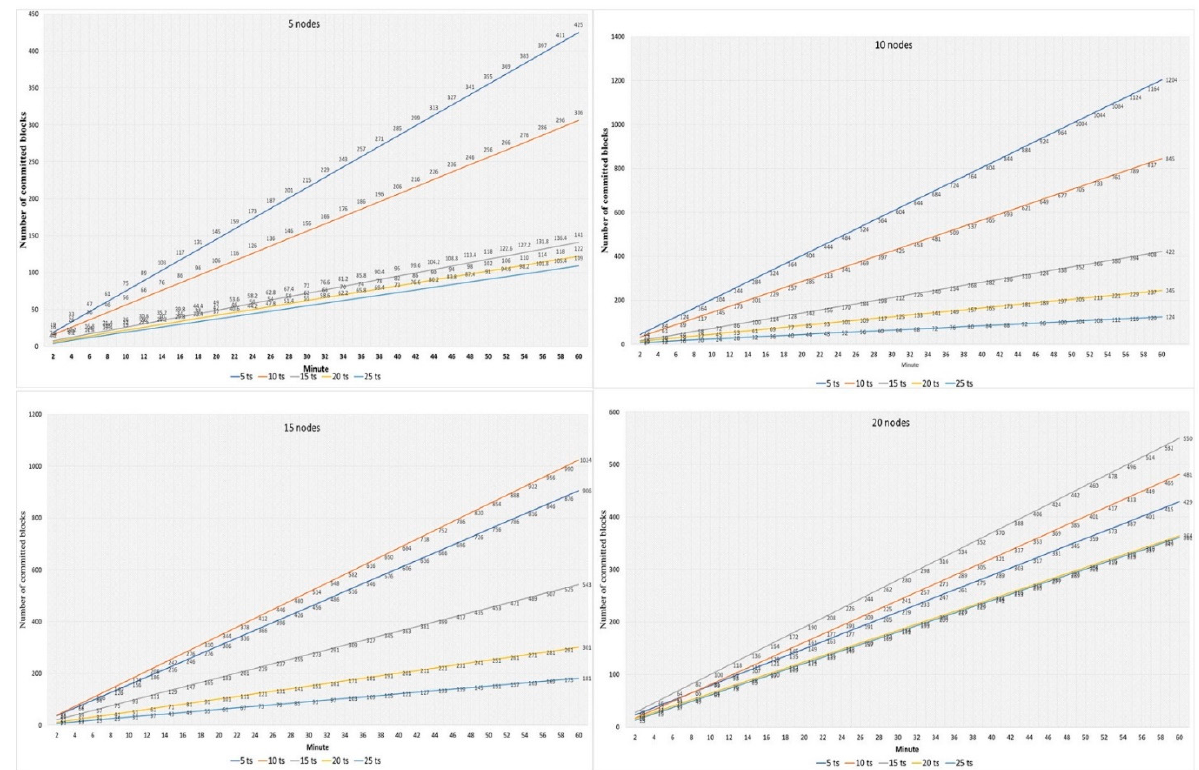
Figure 12. Block committed per minute: with various sized blocks (5 nodes, 10 nodes, 15 nodes, and 20 nodes). Table 4. The typical comparisons with the existing and currently used platform in qualitative